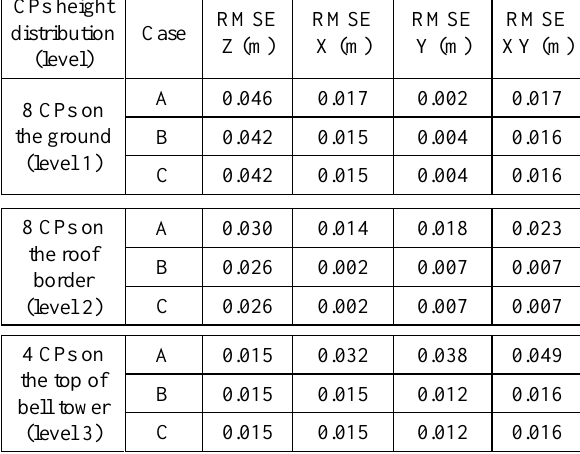
Table 7. RMSE in FreeNet Solution Type